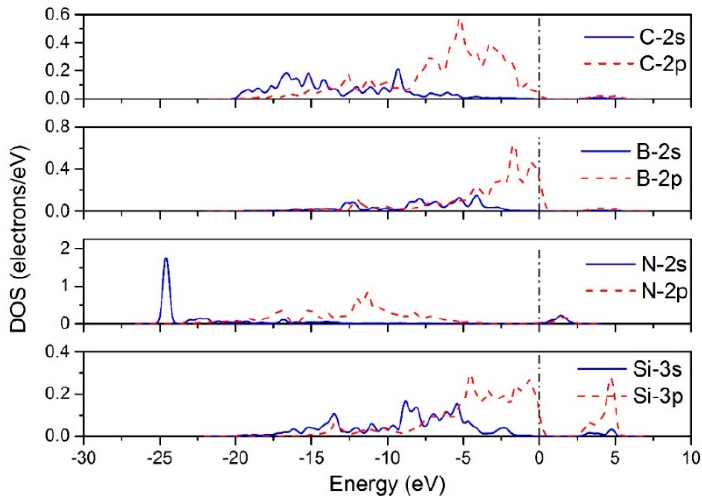
Figure 4. Local density of state of the substituted atom after the adsorption of CH 3.